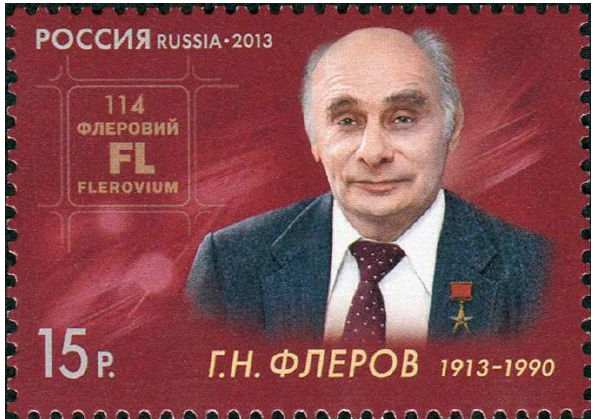
Figure 6. Russian stamp of 2013 dedicated to G. Flerov after whom element 114, flerovium, is named. Flerov was also head of the research team credited with the discovery of nobelium. Source: htt-